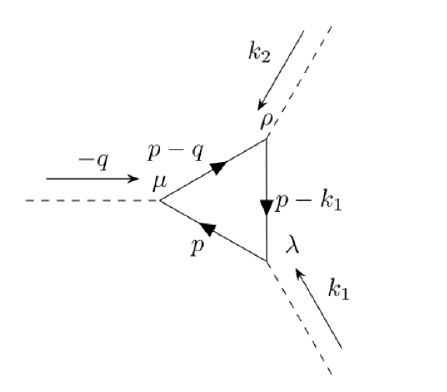
( R ) abc ( k ) 1 , k 2 µλρ